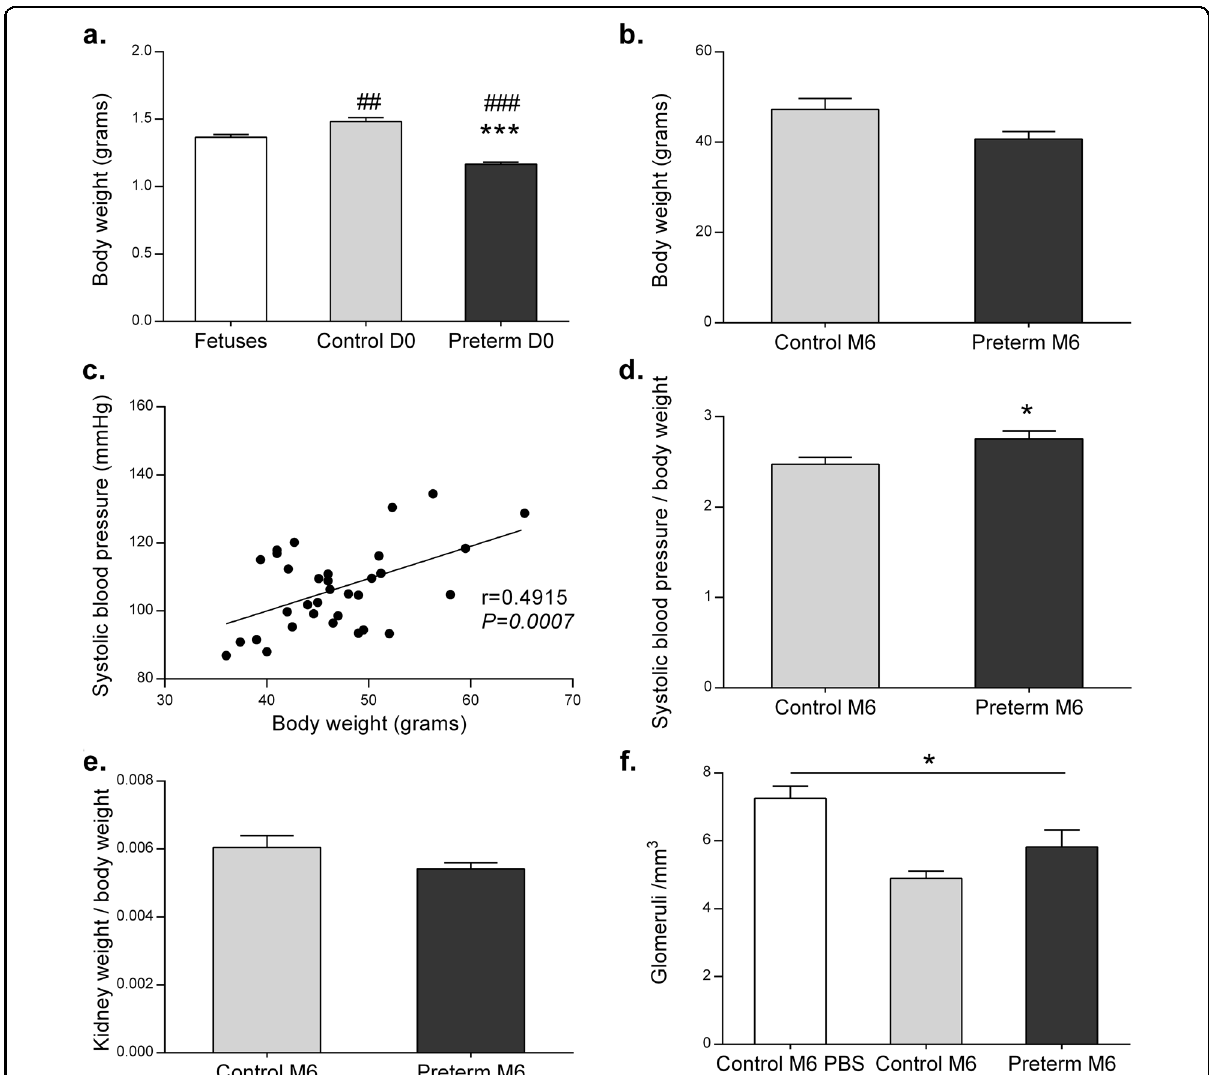
Fig. 3 Clinical characteristics of premature mice. Birth body weight of premature or control mice, compared to E18.5 fetuses, expressed in grams, as the means ± SEM (fetuses n = 6, preterm D0 n = 14, control D0 n = 17) ( a ). Body weight of 6-month (M6)-old former premature males and control mice, expressed in grams, as the means ± SEM ( n = 8 in each group) ( b ). Positive correlation between systolic blood pressure and body weight in M6 mice, obtained by Spearman regression analysis ( c ). Systolic blood pressure normalized to body weight ratio in former premature and control M6 male mice ( n = 6 in each group) ( d ). Kidney weight to total body weight ratio in former premature and control M6 male mice ( n = 6 in each group) ( e ). Glomerular density per mm³ measured in renal sections of former preterm and control M6 male mice ( n = 3 in the control PBS group, n = 5 in the control LPS group, n = 4 in the preterm group) ( f ). * P < 0.05, ** P < 0.01, *** P < 0.001 (compared to the control group); # P < 0.05, ## P < 0.01, ### P <